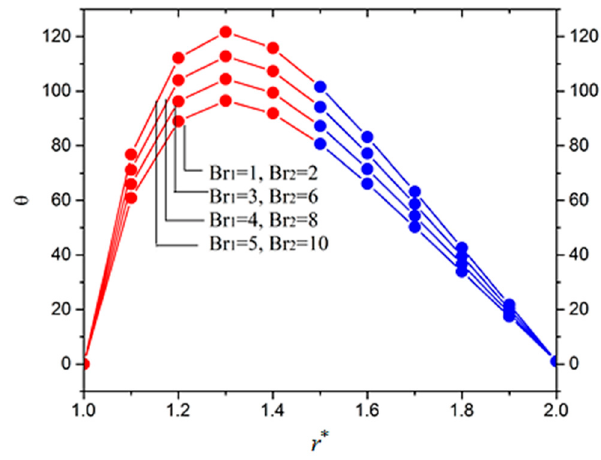
Figure 7. Effect of 𝐵𝑟 (cid:2869) and 𝐵𝑟 (cid:2870) on temperature 𝑋 (cid:2869) = 0.5, 𝑋 (cid:2869) = 1.0 , ε𝐷 (cid:2870)(cid:2870) = 10 , δ = 2 .